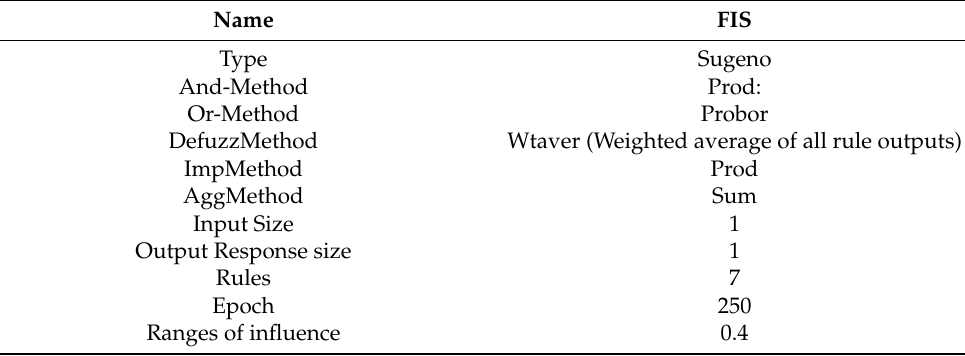
Table 3. Training parameters for ANFIS software.